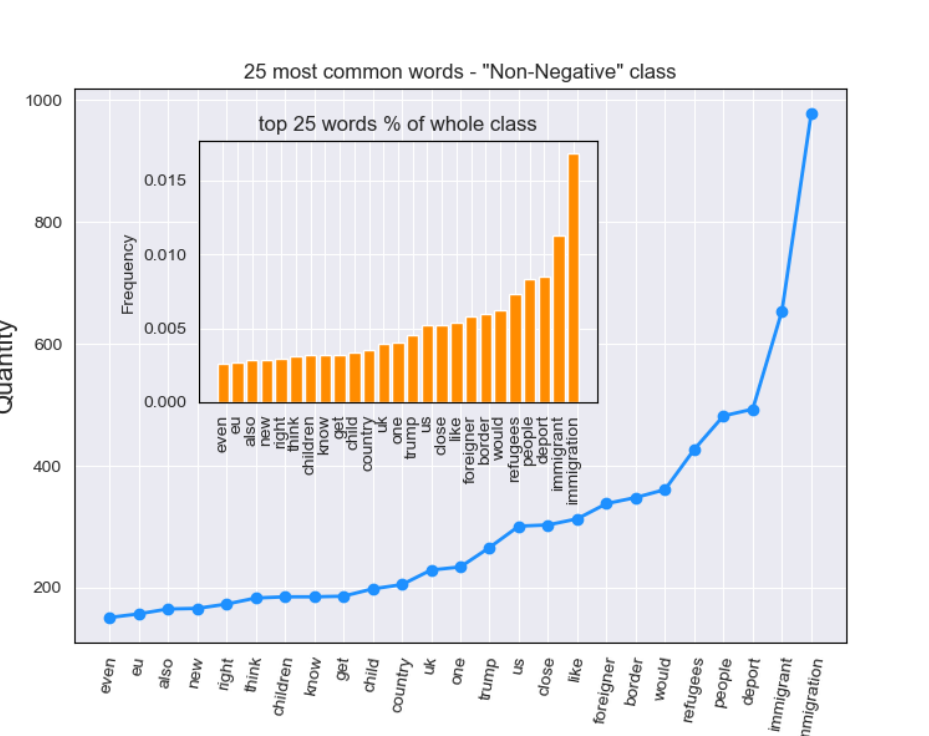
Figure 3. Top most frequent words for “Non-Negative”